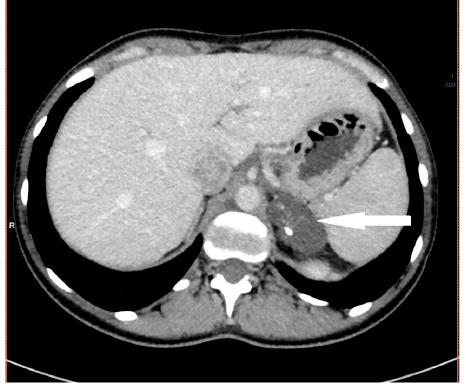
Figure 5. Endothelial cyst. Abdomen CT, transverse cross-section.